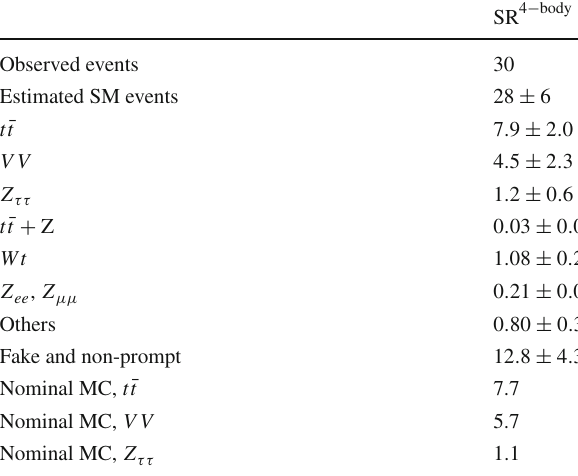
Table19 Model-independent95%CLupperlimitsonthevisiblecross- section ( σ vis ) of new physics, the visible number of signal events ( S 95 o bs ), the visible number of signal events ( S 95 e xp ) given the expected number of background events (and ± 1 σ excursions of the expected number), and the discovery p -value ( p ( s = 0 ) ), all calculated with pseudo- experiments, are shown for each SR